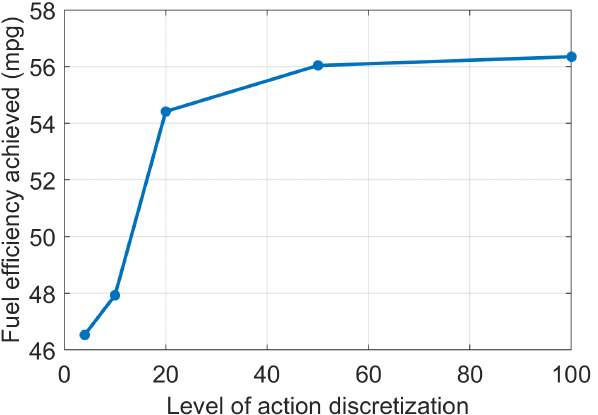
Figure 6. Results from Xu et al. show that the fuel economy of a Q-learning-based parallel HEV EMS depends on the level of action discretization used. The RL-based EMS controls a continuous actuator, τ EM , using a discrete action output. Adapted from